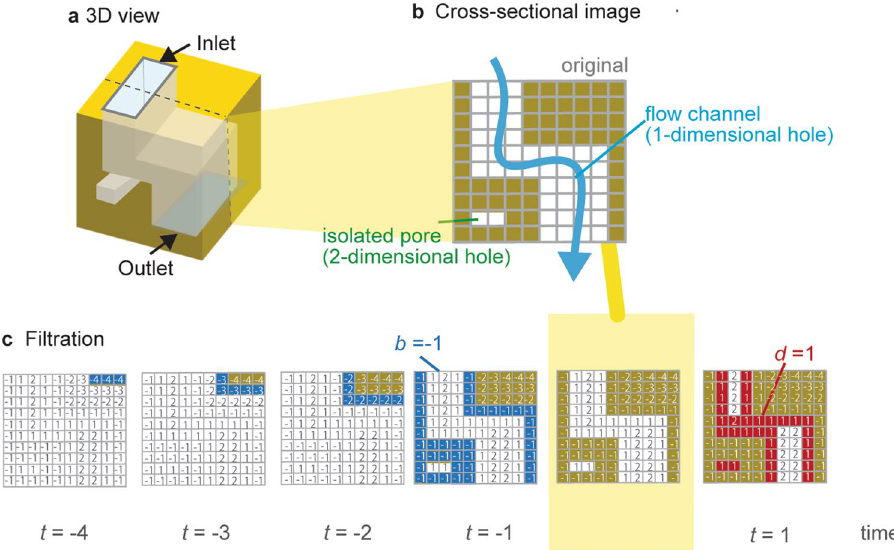
Figure 1. Persistent homology analysis for fracture networks by HomCloud 32 . ( a ) 3D view and ( b ) cross- sectional image of fracture network with a flow channel (light blue arrow) and an isolated pore (shown as green). ( c ) Schematic of filtration process. White grids express void spaces. Blue grids are the grids that were removed during the current thinning iteration. Red grids are the grids that were added during the thickening